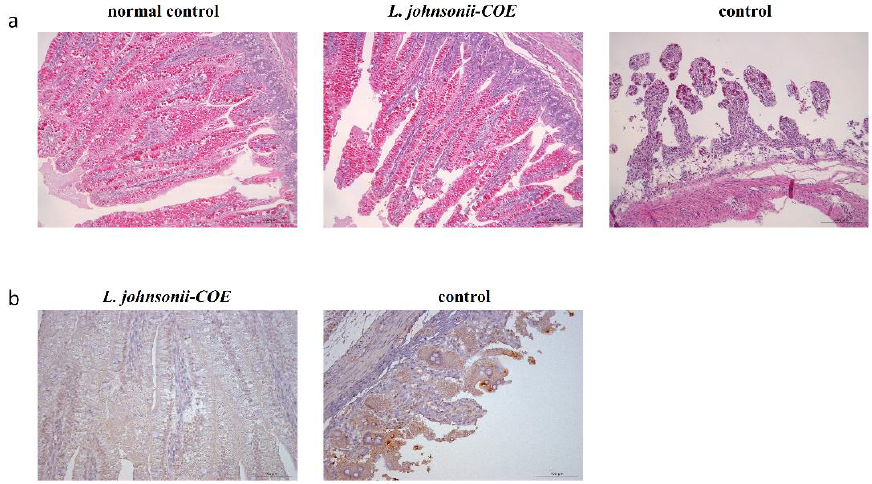
Figure 10. Histopathological observation (scale is 200 um) ( a ) and the detection of virus in the ileum of the piglets by immunohistochemistry (scale is 100 um) ( b ) at the 60th hour post-challenge with PEDV.